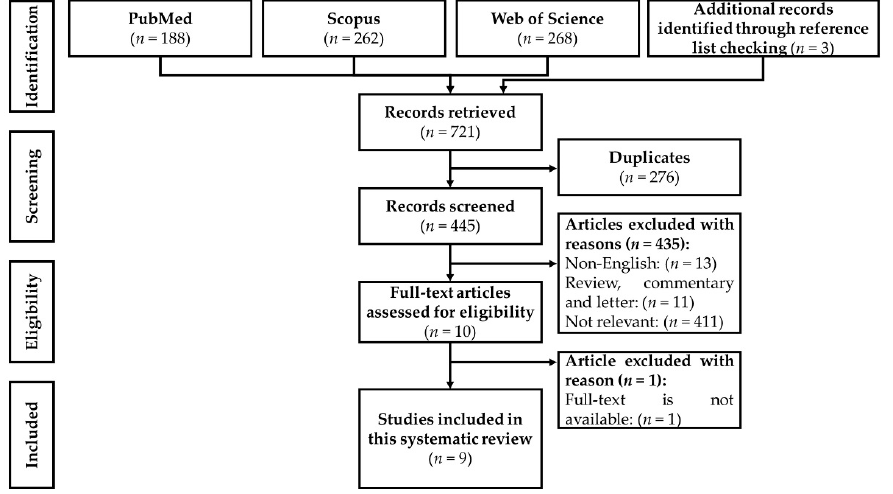
Figure 1. PRISMA flow chart of the systematic literature search. 145